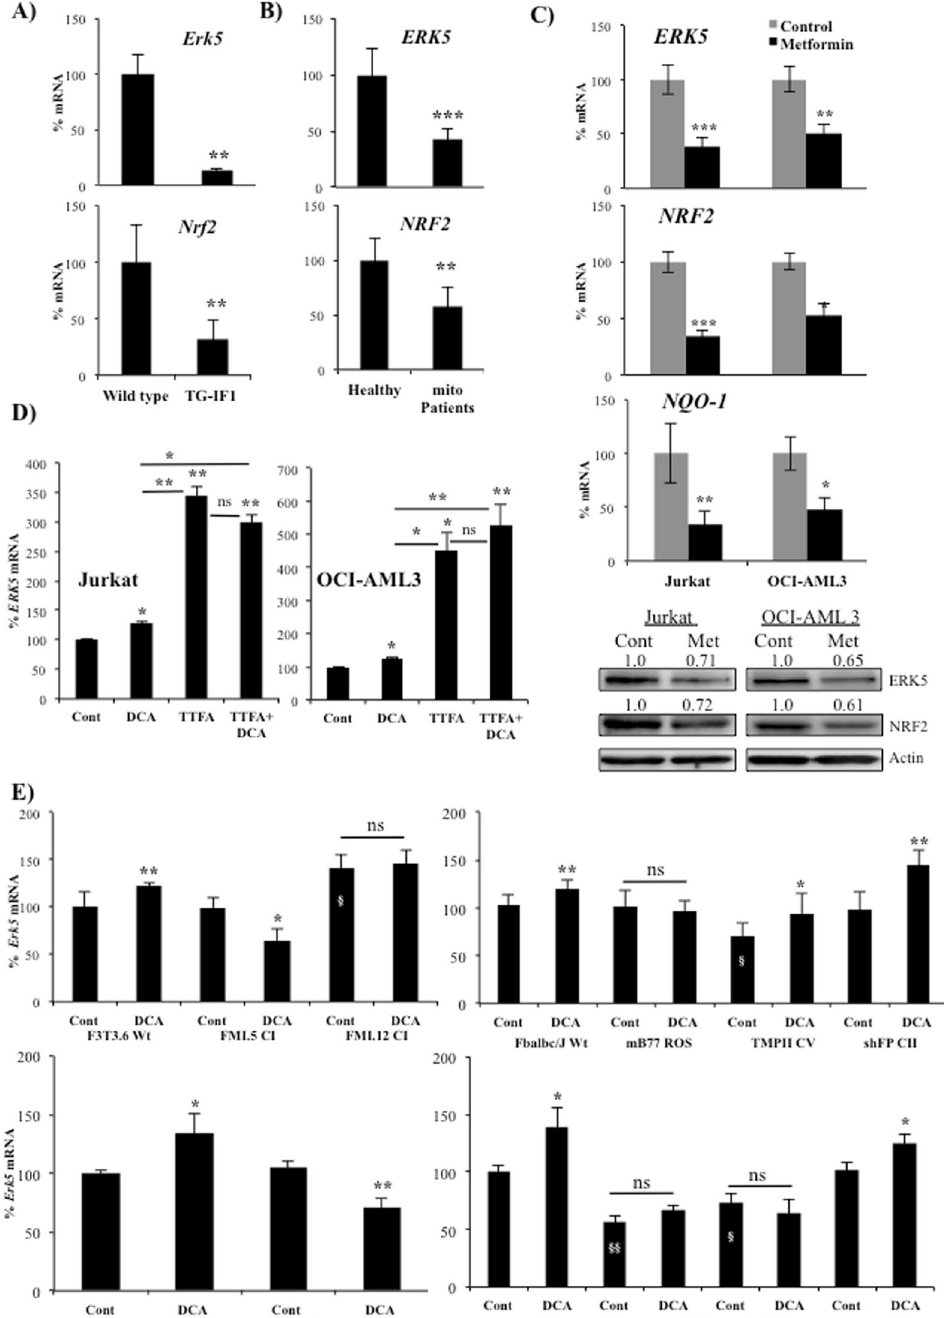
Figure 6. Inhibition of mitochondrial complex I and II signals ERK5 expression. ( A ) Erk5 and Nrf2 mRNA expression in the liver of wild-type and T/H (Tet-Off-H49K (h-IF1) mice. mRNA from 3 mice of each genotype was quantified by qPCR and represented as the % of mRNA compared to wild-type mice. ( B ) ERK5 and NRF2 mRNA expression in fibroblasts derived from a group of 8 healthy donors or 8 patients suffering from mitochondrial defects (Supplemental Table 1). ( C ) Different hematopoietic cell lines were incubated for 24 h with 5 mM metformin. mRNA expression was quantified by qPCR and represented as the % of mRNA compared non-treated cells. ERK5 and NRF2 protein expression was analyzed in these cell lines by western blotting (lower panel). ( D ) Jurkat and OCI-AML3 cells were treated with 10 mM DCA and 300 µ M TTFA for 24 h. NRF2 mRNA expression was quantified by qPCR and represented as the % of mRNA compared to control cells. ( E ) Different cell lines described in Supplemental Table 2 were treated with 20 mM DCA during 24 hours. ERK5 mRNA was quantified by qPCR and represented as the % of mRNA compared to non-mutant control cells. Experiments were done in triplicate and data represent means ± SD; statistics were performed using student t-test ( A – C ) or One-way ANOVA with post-hoc Tukey test ( D and E ); * p < 0.05, ** p < 0.01, *** p < 0.001; § p < 0.05, §§ p < 0.01 compare to the respective control cell lines. Treatments were compared to non-treated cells (control) if not specified in the